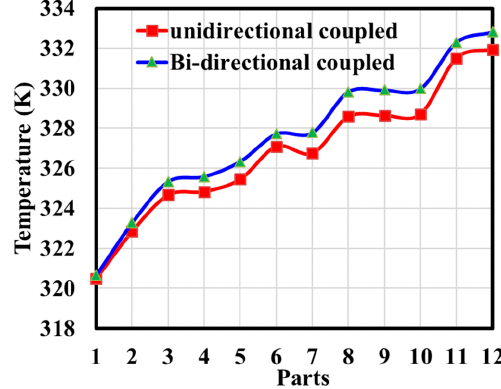
Figure 10. Temperature of different parts.